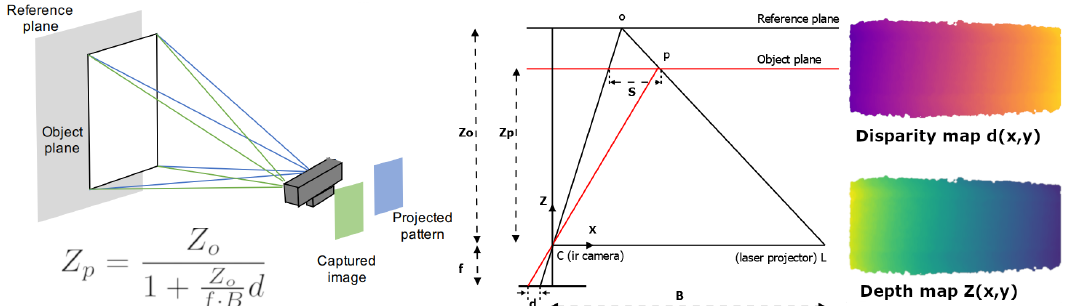
Figure 1. Red-green-blue-depth (RGB-D) camera components and main parameters involved in the disparity and depth map computations. The laser projector L projects a speckle pattern that is registered at a certain distance Z o . During a measurement, the sensor compare the position in the image space between the observed points p and its original registered position (disparity). Using triangulation is possible to estimate the depth Zp of such